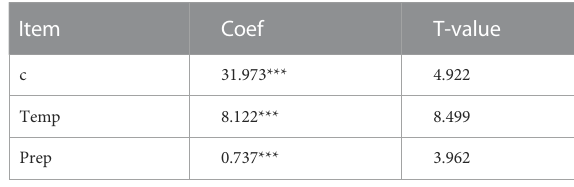
TABLE 3 Statistical analysis of temperature, precipitation, and